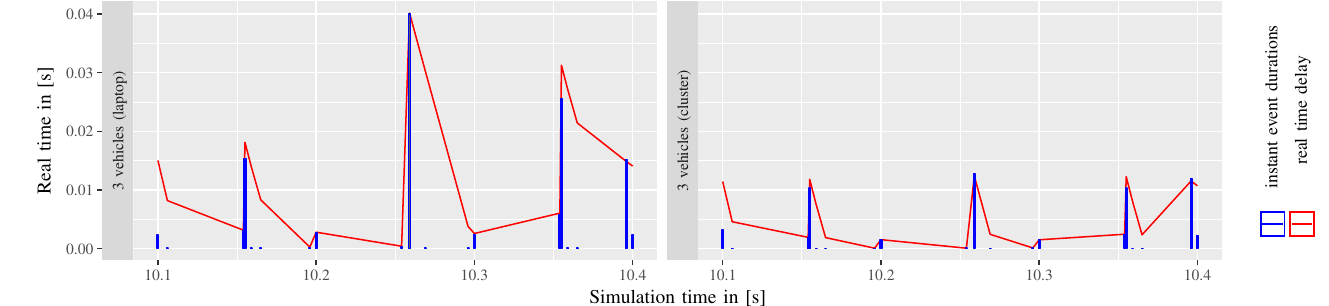
Figure 9. Real-time capabilities of a three vehicle scenario on two different setups. Taken from [40].